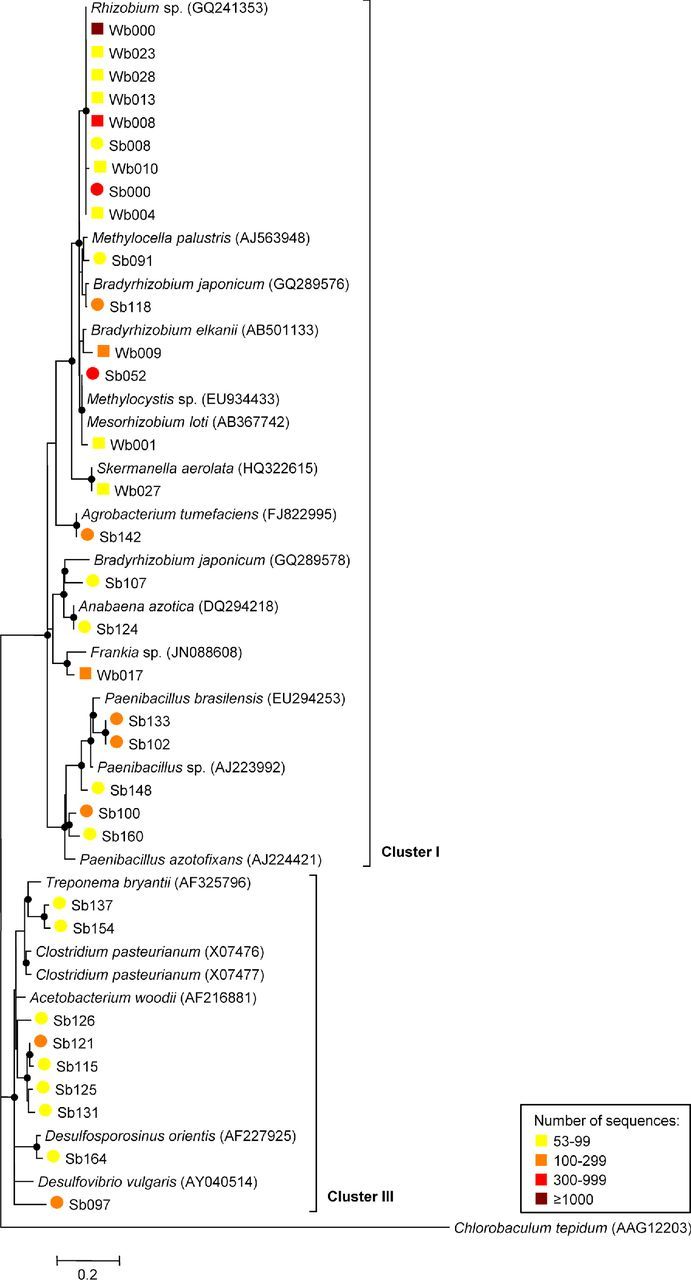
Phylogenetic composition of diazotrophic communities in desert (Wb, squares) and agricultural soil (Sb, circles). Each dataset comprised 5217 high-quality NifH sequences clustered at 8% dissimilarity. The neighbor-joining phylogenetic tree was constructed with both one representative sequence per each OTU and the closest database match (accession numbers in brackets). A partial sequence of the light-independent photochlorophyllide reductase subunit L (BchL) from C. tepidum (AAG12203) was used as an outgroup. Reliability of the tree topology was evaluated using bootstrap analysis with 100 re-samplings (bootstrap values > 50% are indicated as black circles). Sequences were affiliated to the canonical nifH clusters I and III. Numbers of sequences in each cluster are indicated in a heatmap. OTUs containing less than 1% of the normalized dataset were not phylogenetically designated. The scale bar indicates 0.2 amino acid substitutions per site.